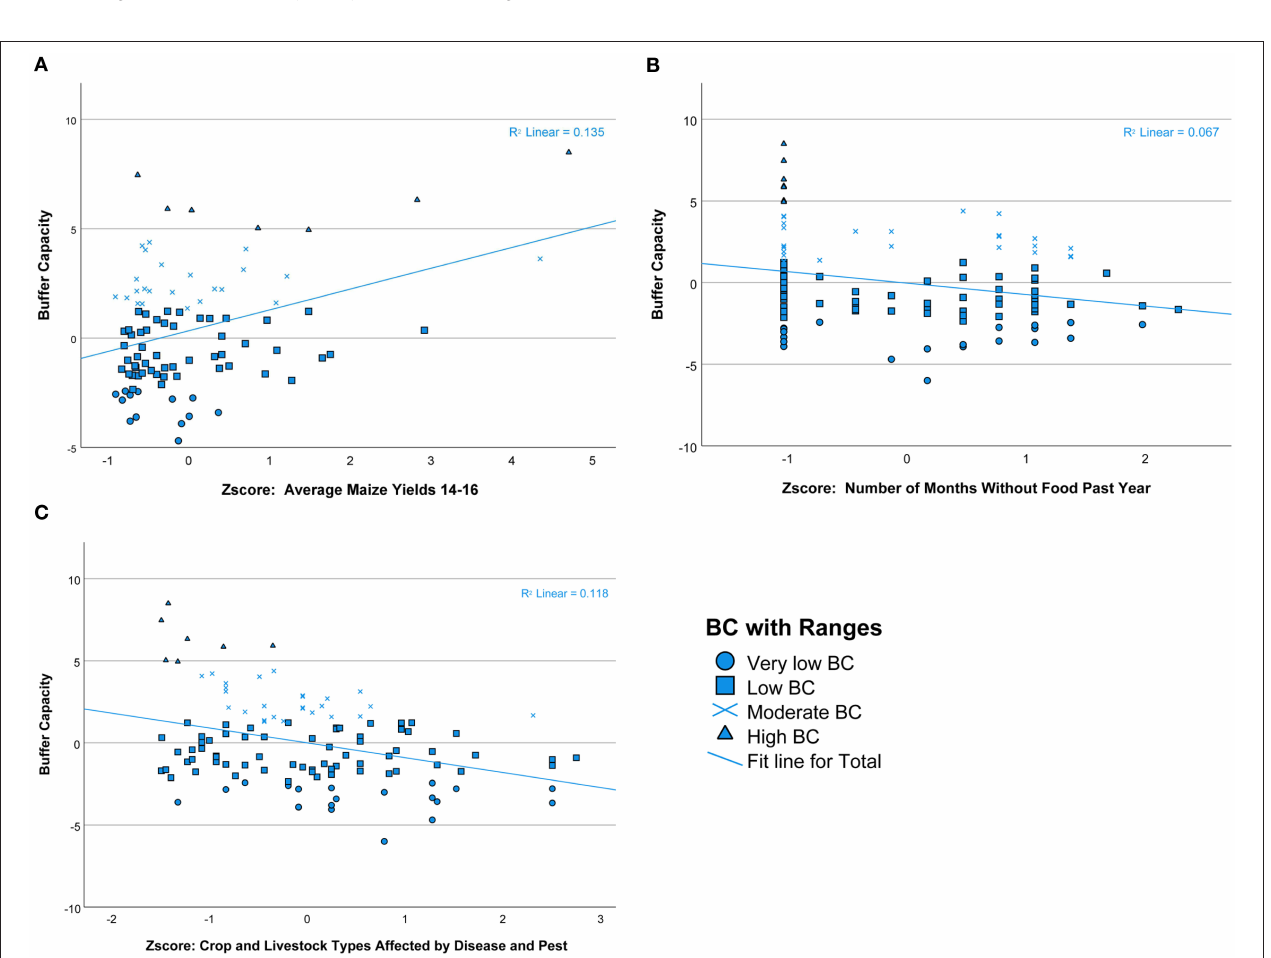
We found significant negative relationships between